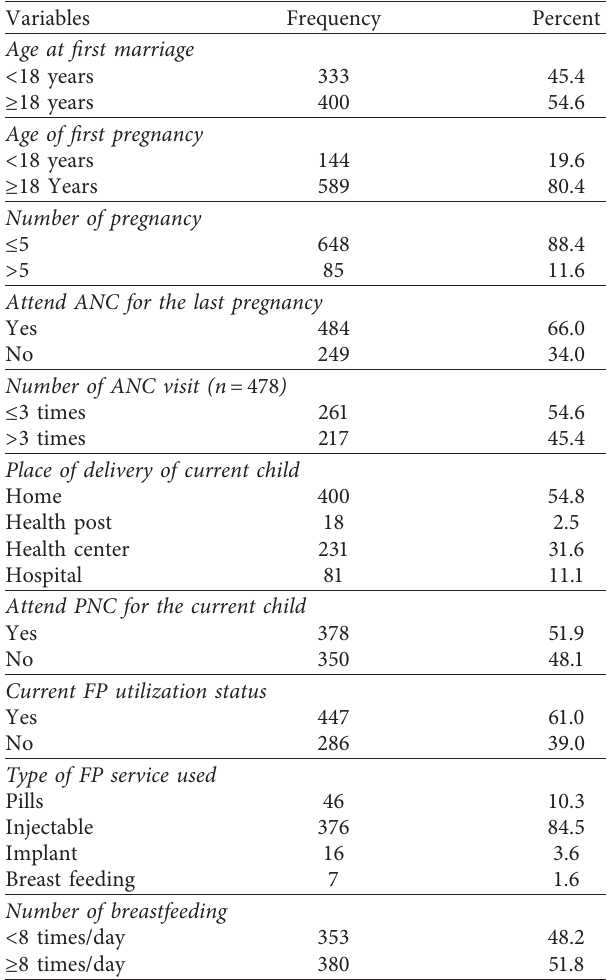
among lactating women had children aged 6 to 23 months in Dega Damot Woreda, Northwest Ethiopia, March-April 2018 ( n �